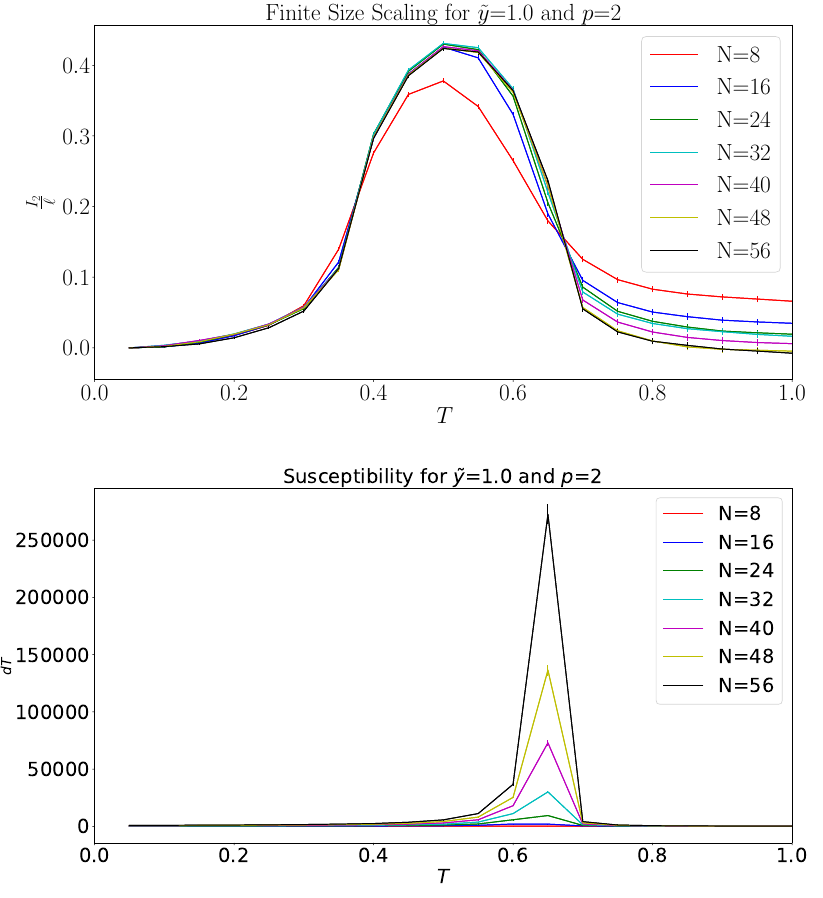
Figure 12 . Top panel: the (cid:12)nite size scaling for RMI of (4.26) with p = 2 and ~ y = 1. This case corresponds to dYM. The curves cross at T T c , respectively. Bottom panel: the magnetic susceptibility of the system. The susceptibility peaks at T = 0 : 65, in agreement with (cid:24)